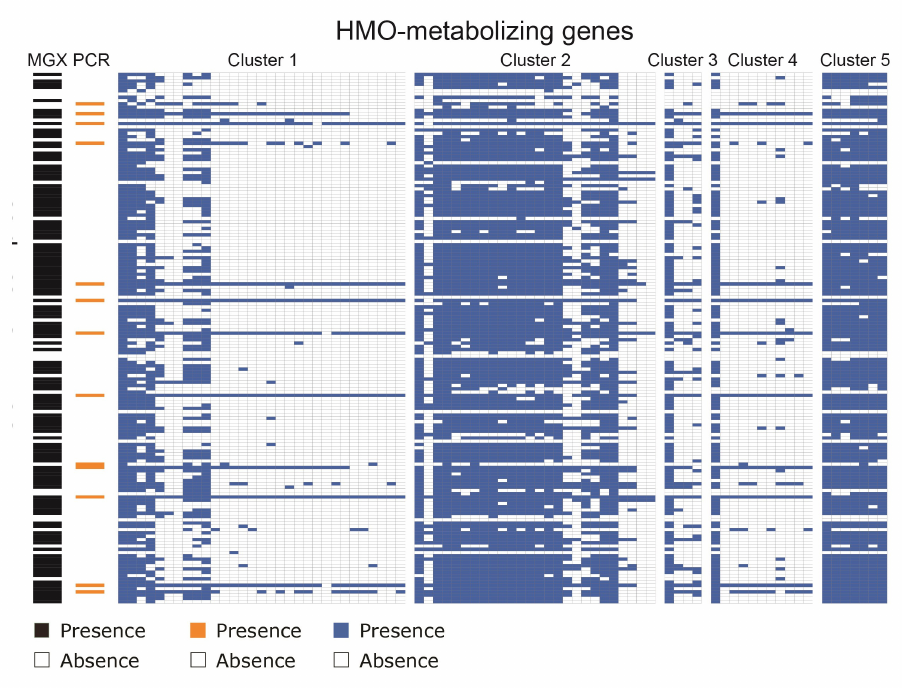
Figure 4. B. infantis presence observed in 15 of 203 (7.4%) samples from children under the age of two via PCR or metagenomics. Results from tests on samples from children under the age of two for the presence of HMO-metabolizing genes either via metagenomics ( n = 203) or PCR ( n = 162). The presence of B. infantis in metagenomes ( n = 15) was determined by mapped Bowtie2 alignments to HMO-metabolizing genes. The PCR presence of B. infantis ( n = 13) was determined by PCR using primers designed to target the gene Blon2348 unique to the subspecies, with presence noted in orange and absence in white. Presence of Bifidobacterium longum calculated by MetaPhlAn is also noted on the left-hand side in the MGX column in black and absence in